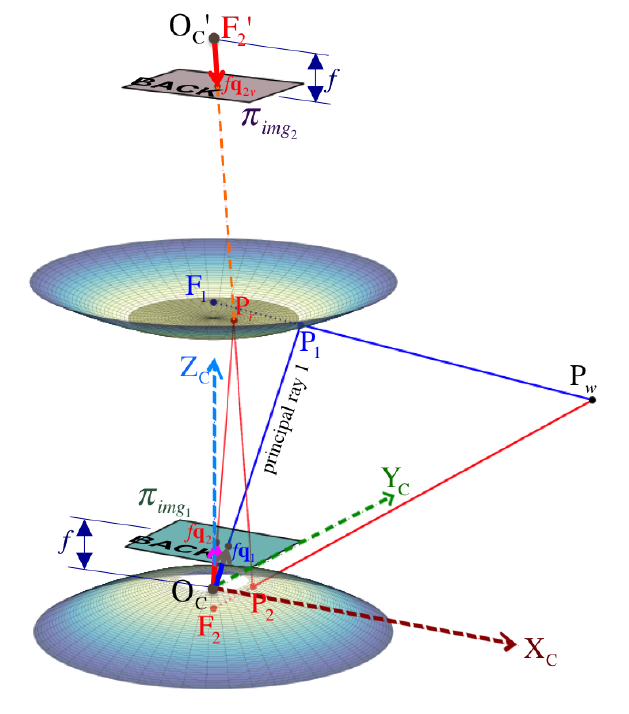
Figure 4. Omnistereo projection of a 3D point P w to obtain image points [ I ] m 1 and [ I ] m 2